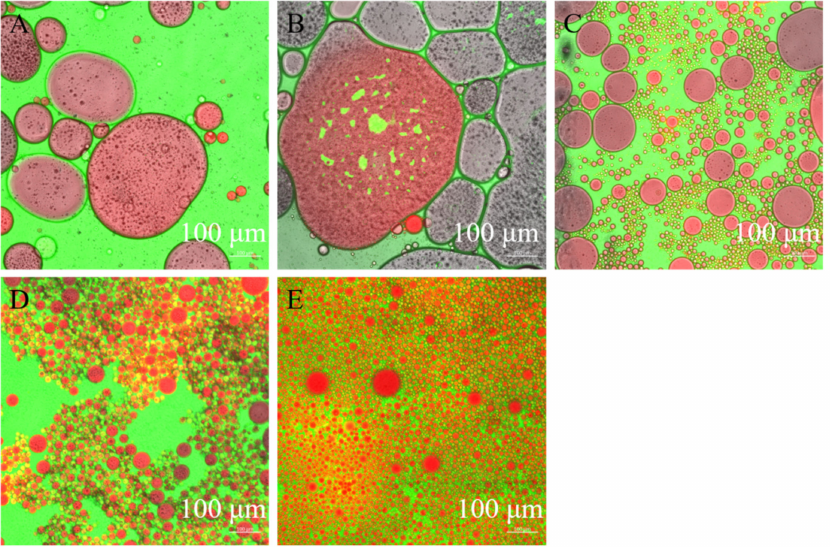
Figure 4. CLSM images of Pickering emulsions stabilized by different concentrations of TSCPN. ( A ), 0.3%; ( B ), 0.6%; ( C ), 1.2%; ( D ), 1.8%; ( E ), 2.4%. Oil was dyed red, and protein was dyed